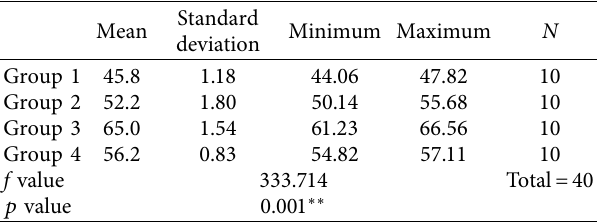
Table 3: Overall comparison of shear bond strength of Co-Cr alloy samples using ANOVA.